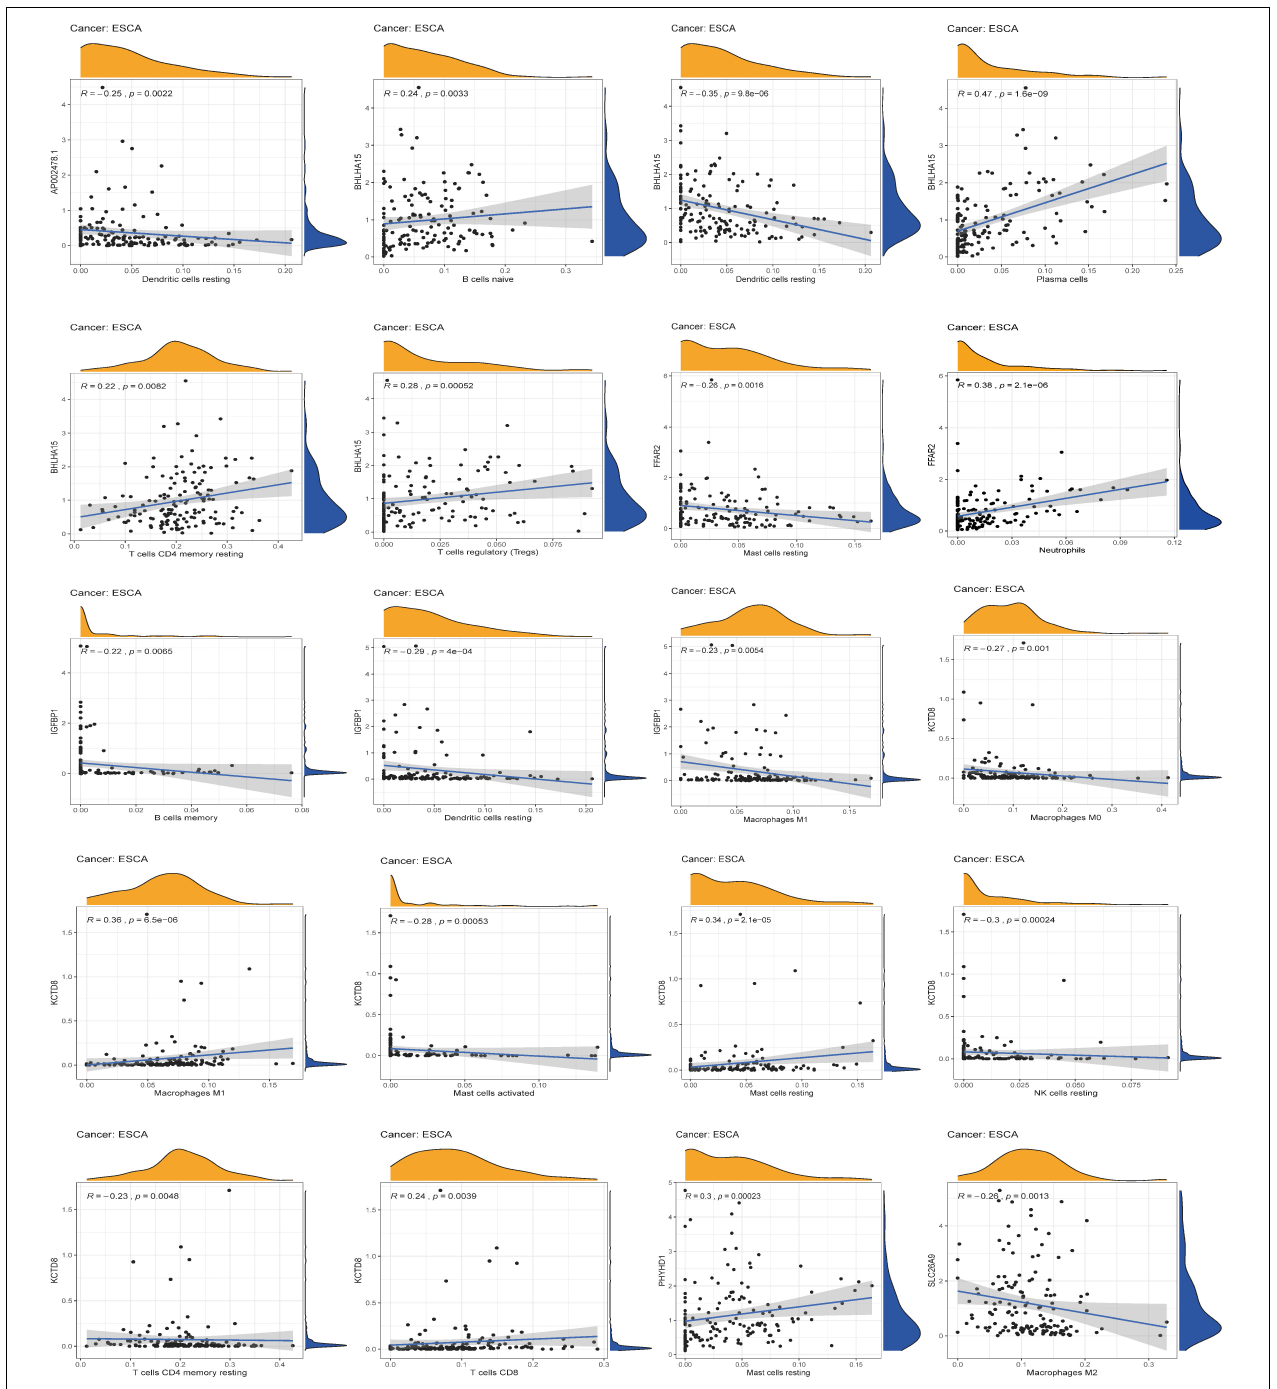
FIGURE 10 | The relationship between the seven genes and immune cell